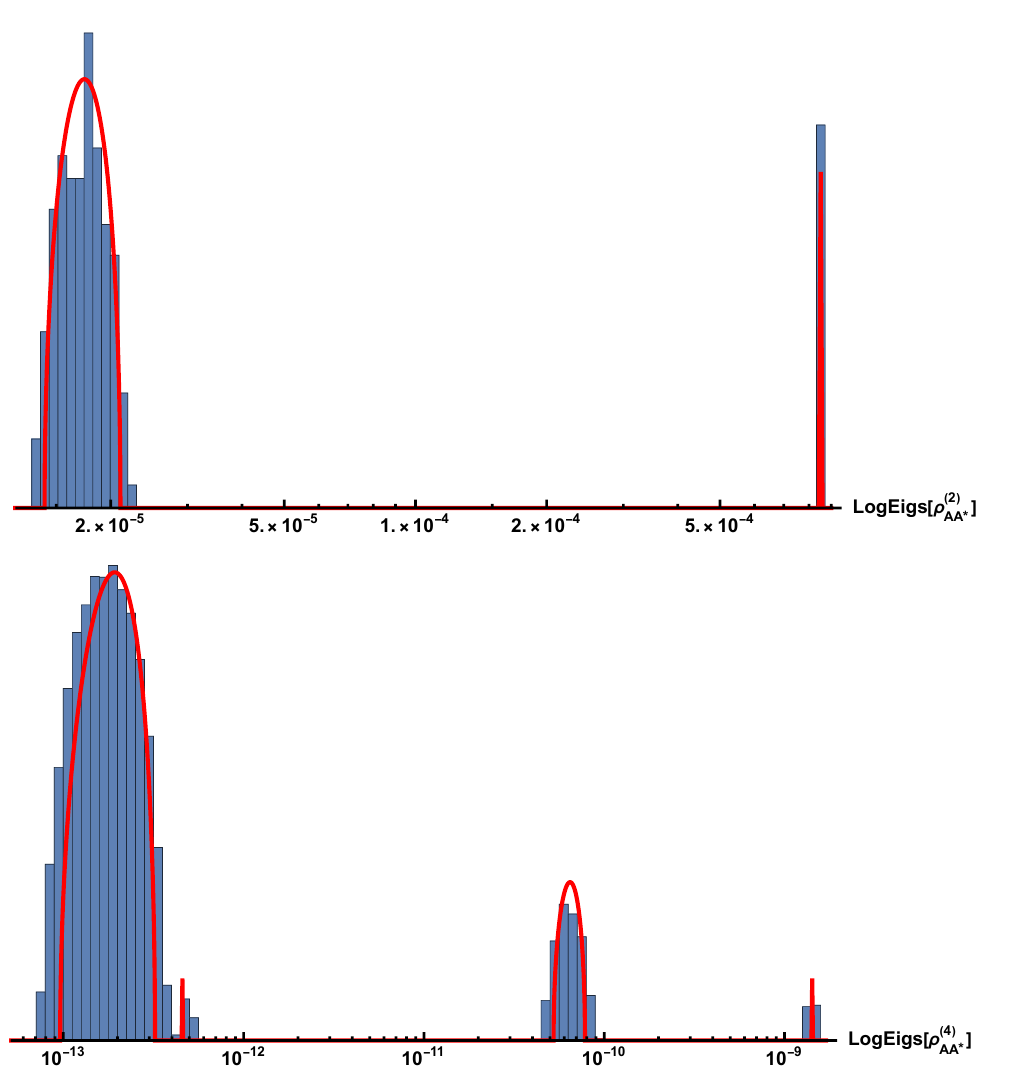
Figure 17 . Plots of spectra of the (unnormalized) density matrix ρ ( m ) m = 2 (top) and m = 4 (bottom), with the red lines being the analytic predictions. Note that in the case of m = 4 there is an additional eigenvalue that lies close to the leftmost peak. This is a finite χ effect that is not visible in our m → 1 analytics. Nevertheless our results for even integer m are χ -exact which is well confirmed by these two